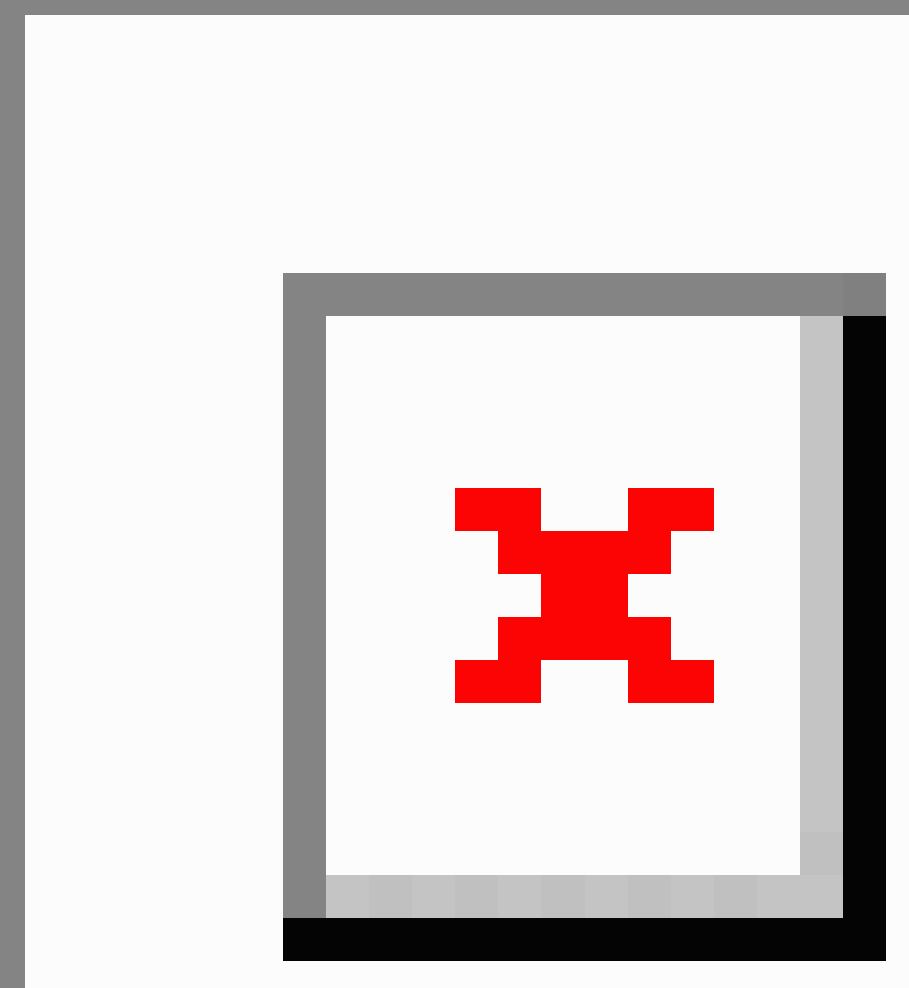
Figure 1. Attrition of participants in the two groups over the 1-year study